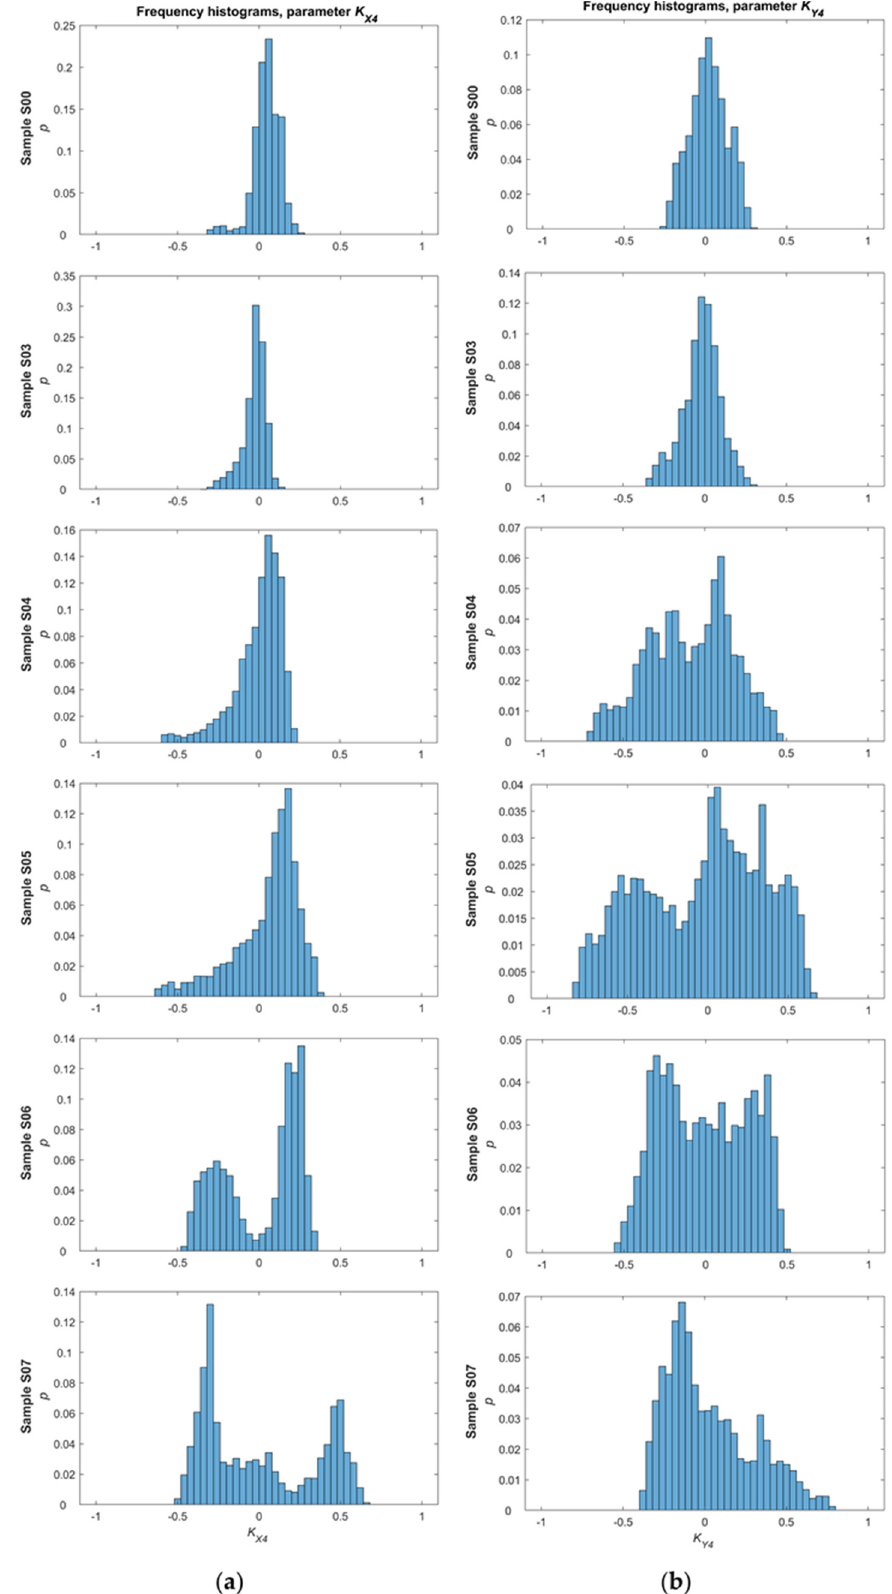
Figure 8. Frequency histograms of the K A 4 parameter for the: ( a ) x -axis direction; and ( b ) y -axis direction.